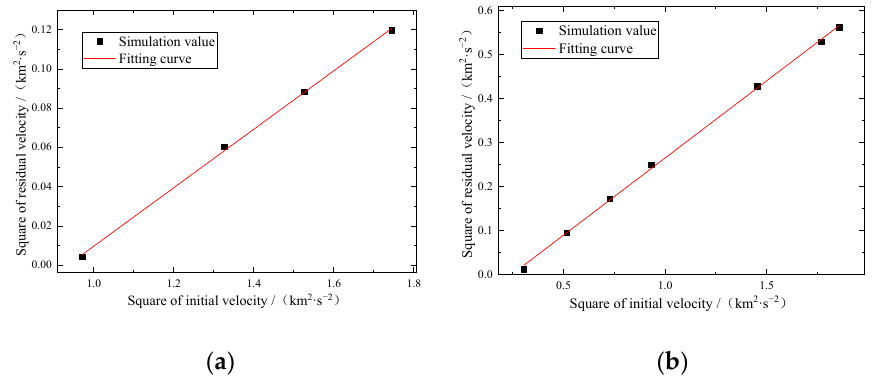
Figure 8. Relationship curve between v 0 2 and v x 2 obtained by fitting. ( a ) is 6 mm fragment; ( b ) is 11 mm fragment.